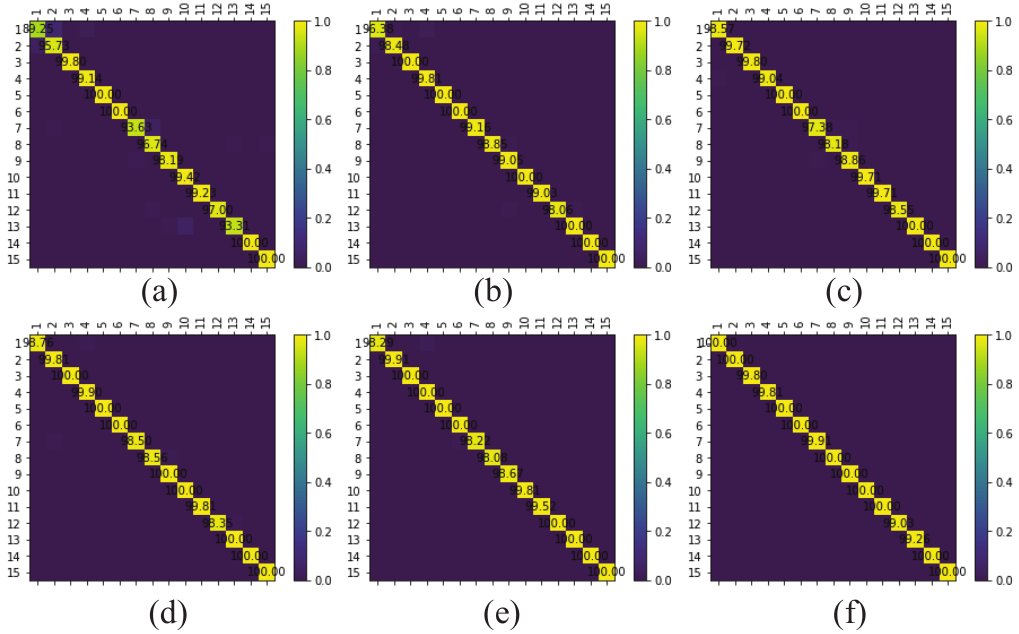
Figure 13. Normalized confusion matrices of classification results for the Grss_dfc_2013 data. ( a ) CNN. ( b ) M3DCNN. ( c ) SSRN. ( d ) MSDN-SA. ( e ) MSO3DCNN. ( f )